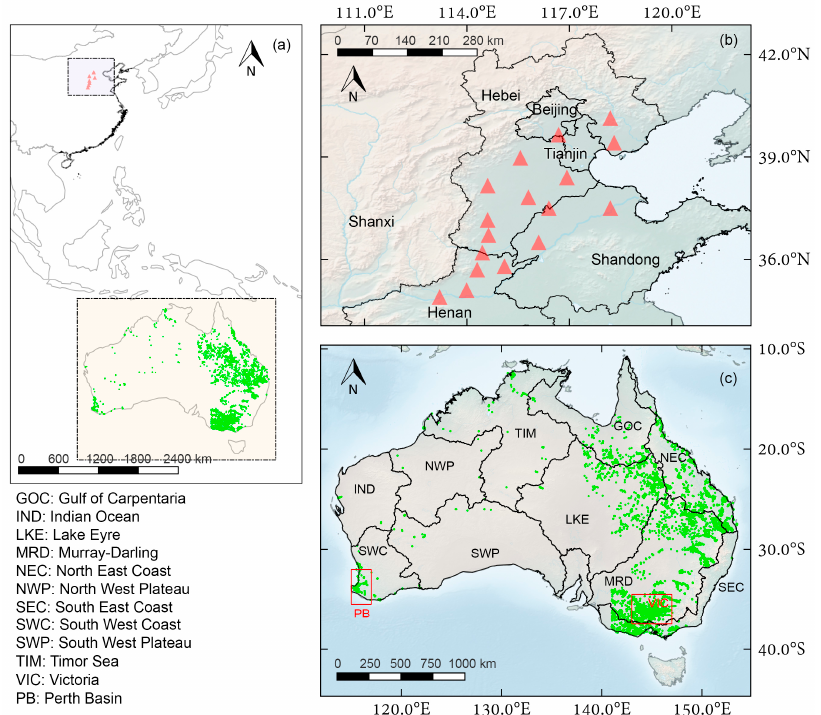
Figure 1. ( a ) Geographical locations of the study areas; ( b ) the North China Plain (NCP); and ( c ) Australia. The groundwater locations (red triangles) in major cities of NCP are shown in ( b ) while the locations of groundwater observation bores (green dots) in Australia are shown in ( c